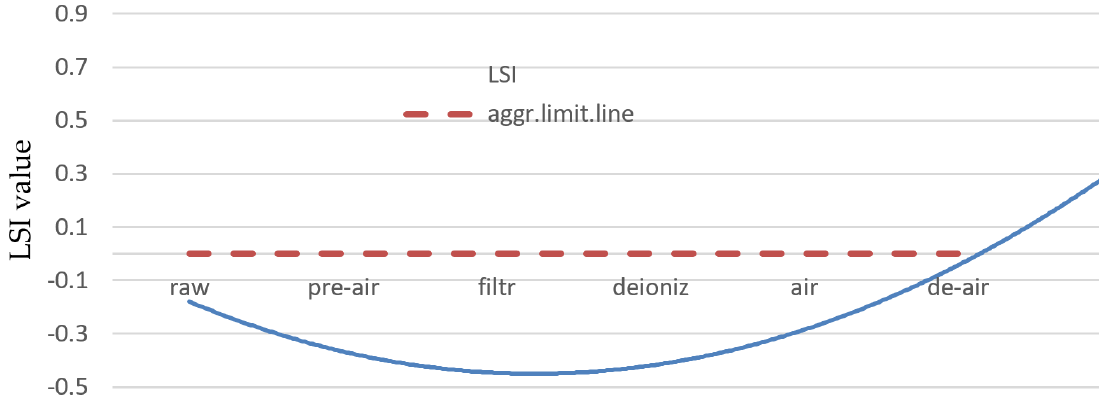
Figure 3. Changes of Langelier Saturation Index (LSI). Source: Own elaboration.